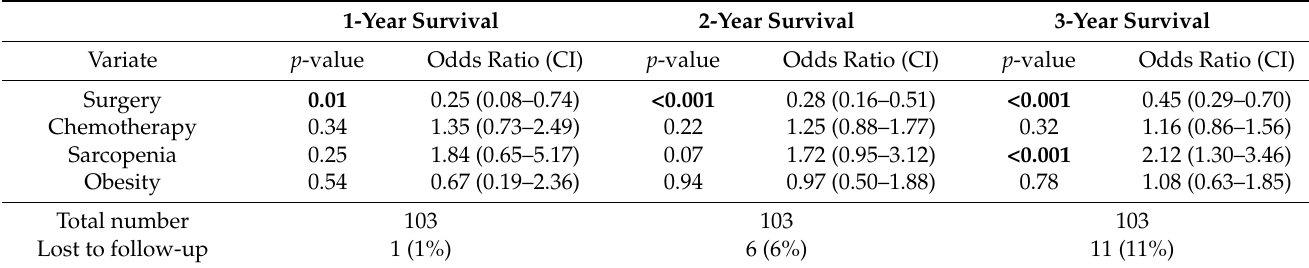
Table 3. Cox regression analysis of all patients with pancreatic adenocarcinoma. Presence of surgery (pylorus preserving pancreatoduodenectomy), chemotherapy, and AI-derived cut-off values for sarcopenia and obesity served as independent variates. AI = artificial intelligence, CI = confidence interval.